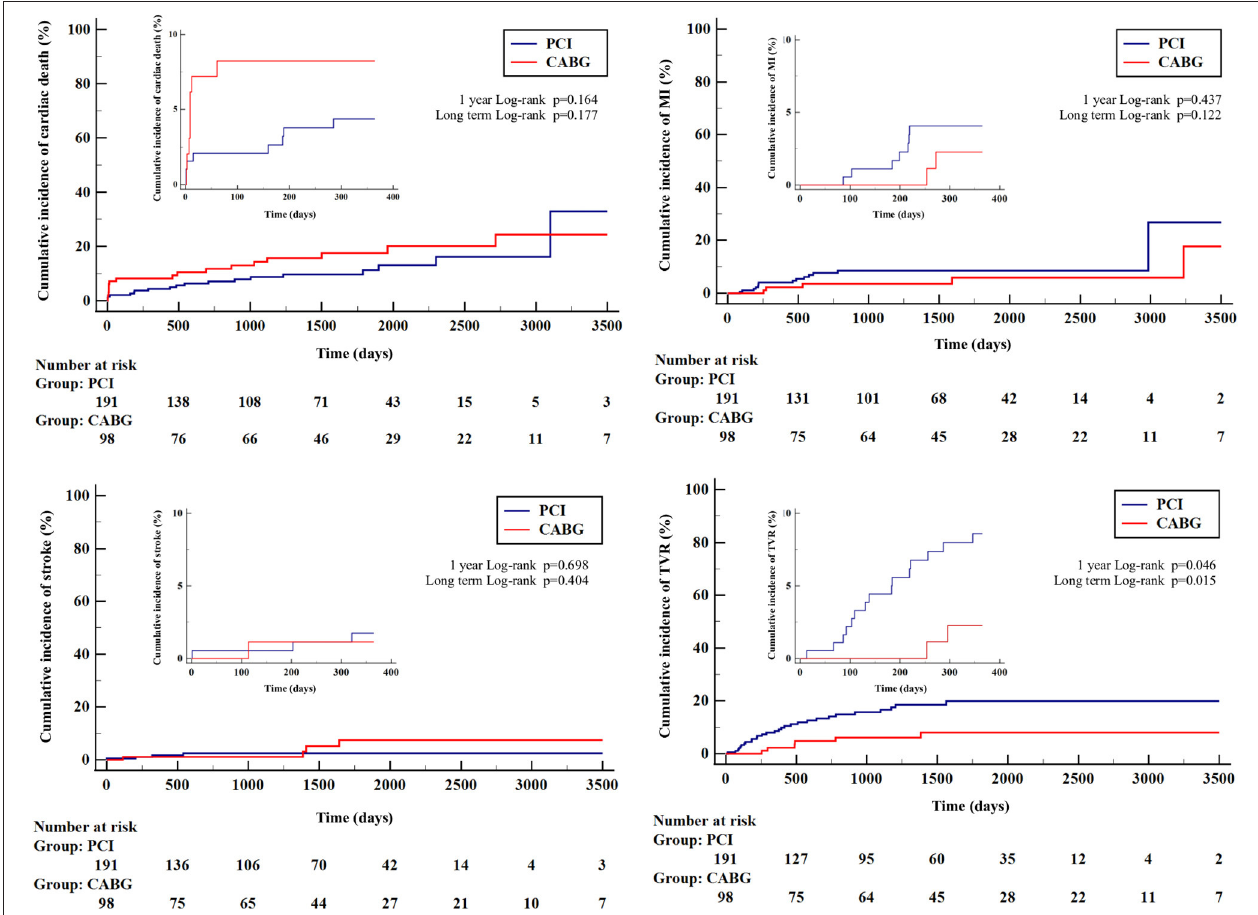
FIGURE 2 | Kaplan–Meier curves for cumulative incidence of secondary outcomes according to type of treatment. CABG, coronary artery bypass grafting; MI, myocardial infarction; PCI, percutaneous coronary intervention; TVR, target vessel revascularization.